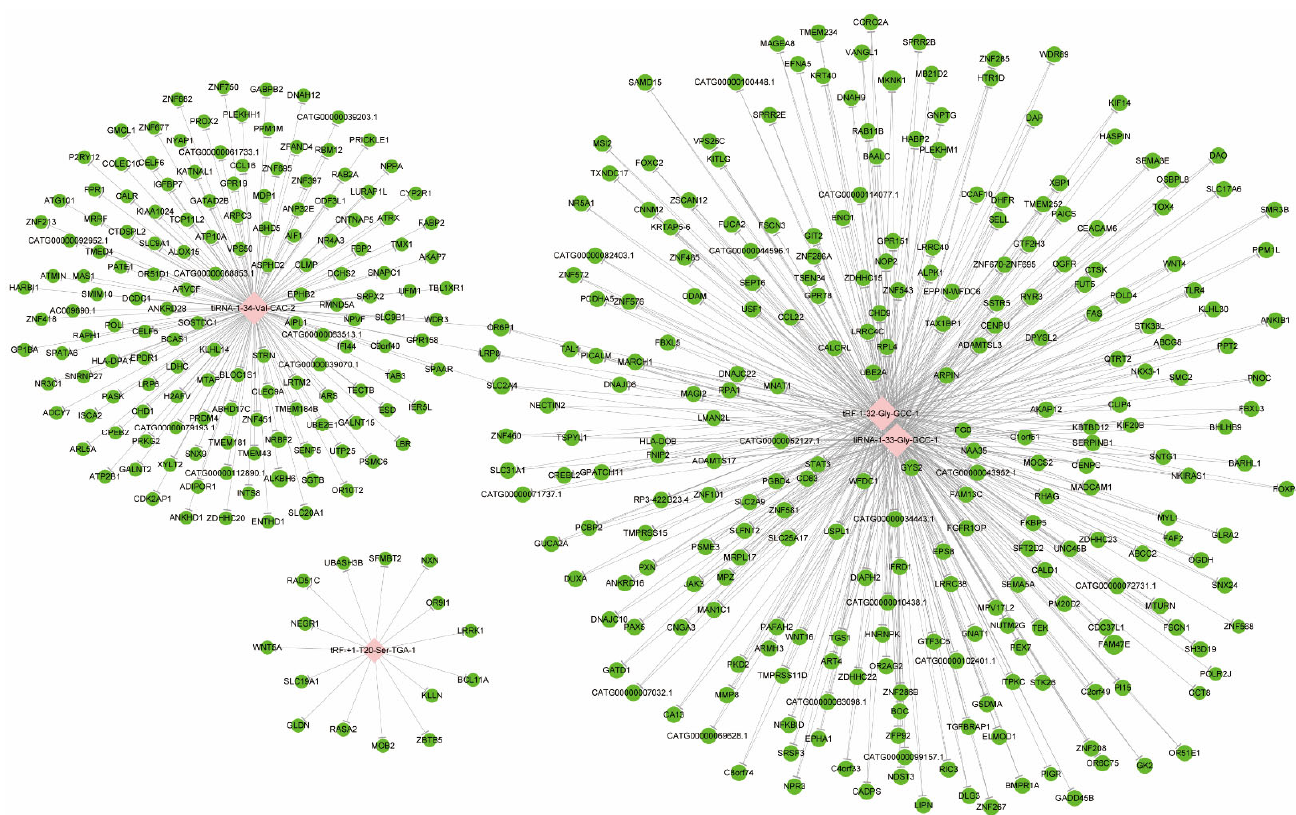
Figure 4. The tsRNA/mRNA network analysis. The network included the four candidate tsRNAs and their predicted target mRNAs (nodes in red color are tsRNAs; nodes in light-green color are target mRNAs).